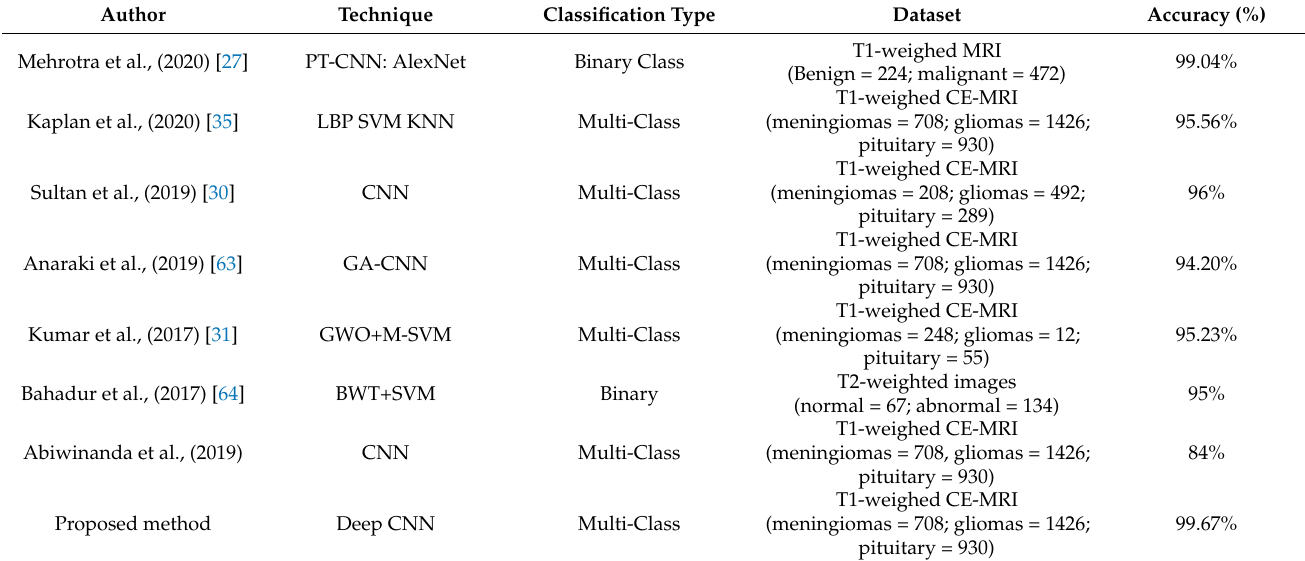
Table 7. Comparative study of the proposed model with recent ML and DL